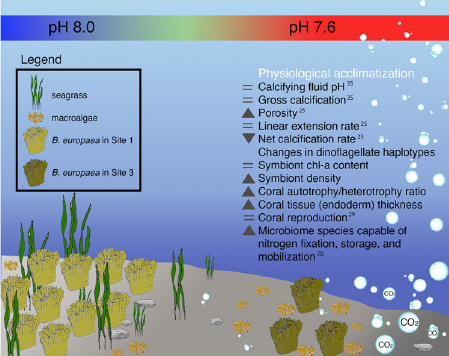
Fig. 6 Conceptual scheme summarizing the effects of life-long physiological acclimatization to low pH/high pCO 2 conditions in B. europaea at the Panarea CO 2 vent. Under low pH conditions, coral population density decreases 33 , net calci fi cation is depressed, while linear extension rate is maintained constant, allowing the coral to reach critical size at sexual maturity and reproduce. Moreover, an overall rearrangement of the coral holobiont is documented by: (i) an increase in symbiont cell density, triggered by thickening of the coral tissue and the establishment of novel dino fl agellate haplotypes possibly better adapted to lower pH conditions, and (ii) an increase, within the coral tissue/mucus in microbial communities capable of dinitrogen fi xation as well as N storage and mobilization. Variations displayed by corals living at average pH 7.6 compared to corals at average pH 8.0 are shown with grey symbols and are listed in the following order: skeleton (from micro to macro), symbionts (from micro to macro), trophic strategy, reproduction, tissue/mucus microbial community. Darker and lighter shades of green in the coral sketches represent higher and lower symbiont cell density. The color scale bar highlighting the seawater pH change across the gradient does not match the color scale of pH test strips. Image was assembled using Adobe Photoshop CC